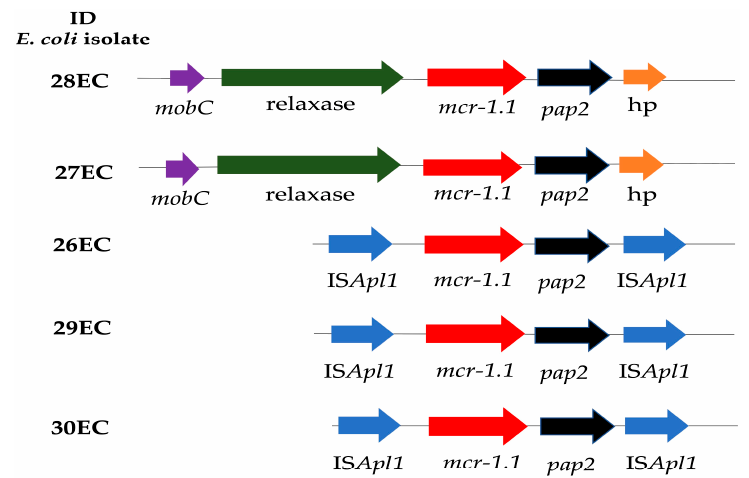
Figure 1. Comparative analysis of the genomic context of mcr-1.1. hp: hypothetic protein. Arrows represent the position and transcriptional direction of the open reading frames (ORF) regions, and mcr-1.1 genes are indicated by red arrows.